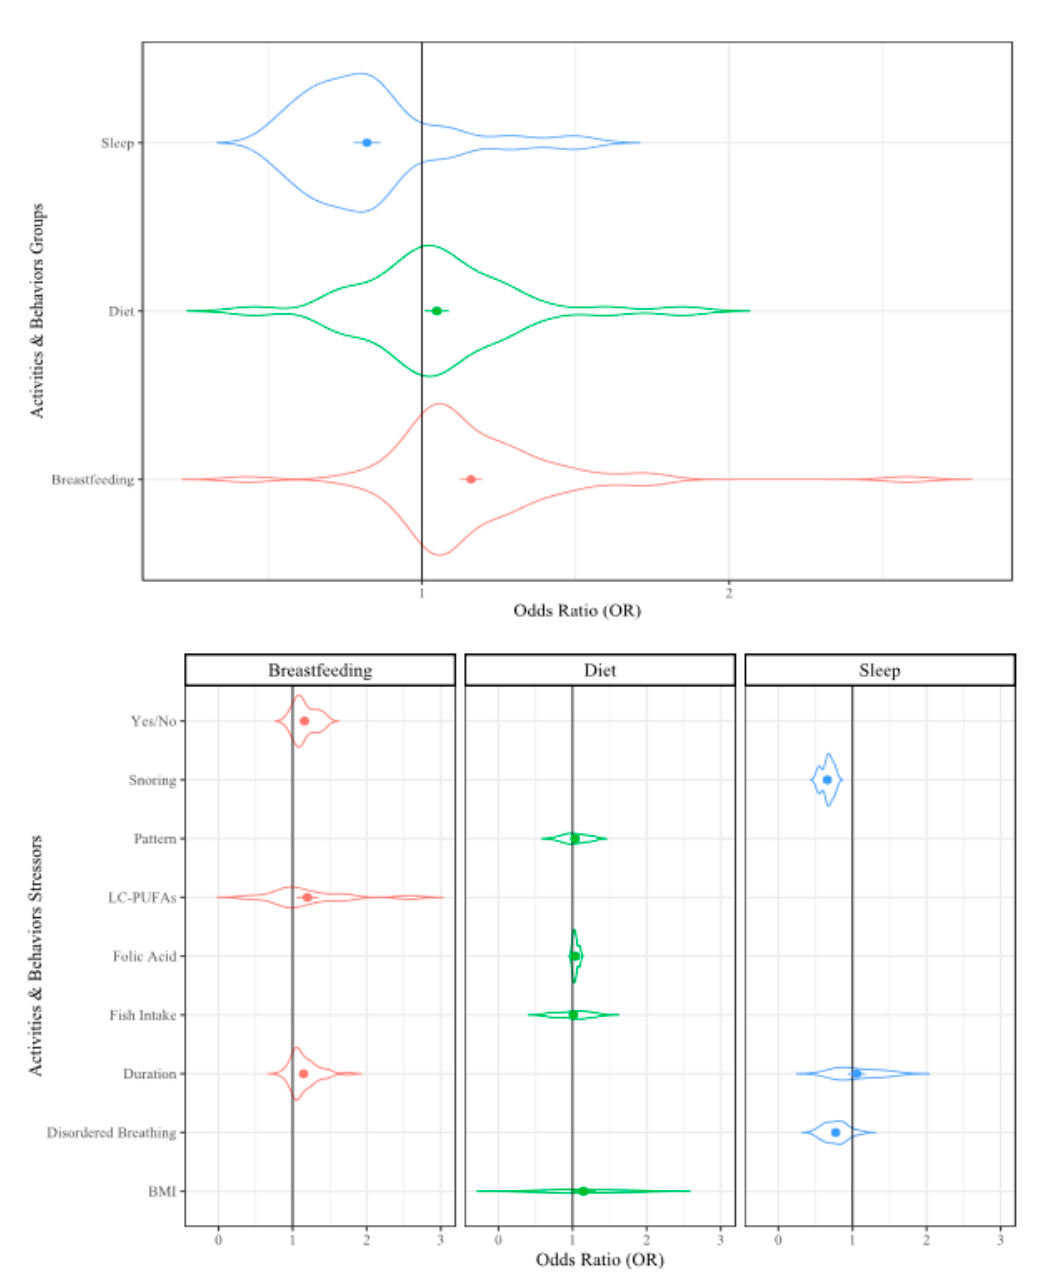
Figure 4. Violin plot of the activities/behaviors that may influence cognitive development. Violin width represents the distribution of the Odds Ratios (OR), the height represents density of the ORs; dots represent mean OR, error bars represent mean SE.